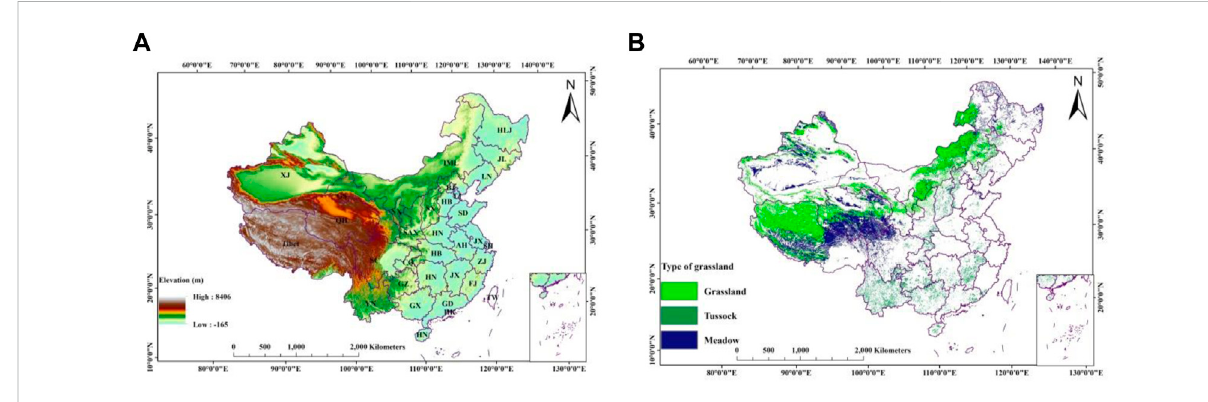
FIGURE 1 (A) Elevation chart of China (excluding Hong Kong, Macao and Taiwan). (B) Spatial distribution characteristics of grassland types in China.